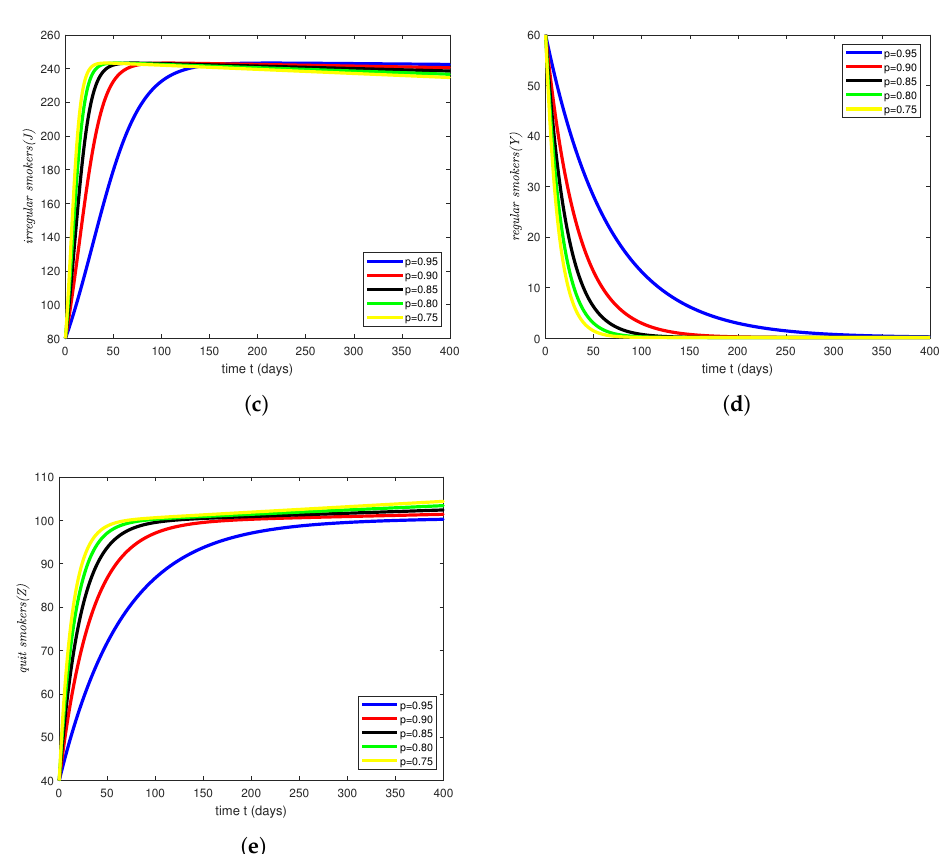
Figure 6. Fractional dynamical behavior of all the compartments of the considered model having different initial conditions along with the same fractional orders. ( a ) Dynamical behavior of class X ( t ) at t = 150 ; ( b ) Dynamical behavior of class H ( t ) at t = 100 ; ( c ) Dynamical behavior of class J ( t ) at t = 80 ; ( d ) Dynamical behavior of class Y ( t ) at t = 60 ; ( e ) Dynamical behavior of class X ( t ) at t = 40.